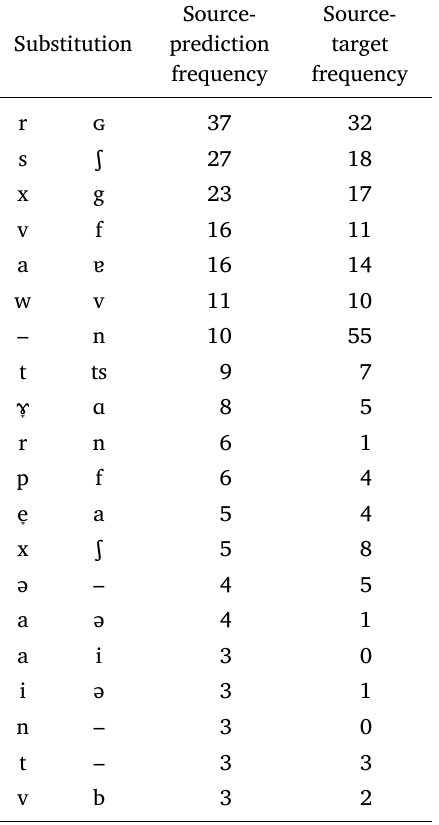
Substitutions between aligned source-prediction pairs and substitutions between aligned source-target pairs for Dutch-German word prediction, using a structured perceptron